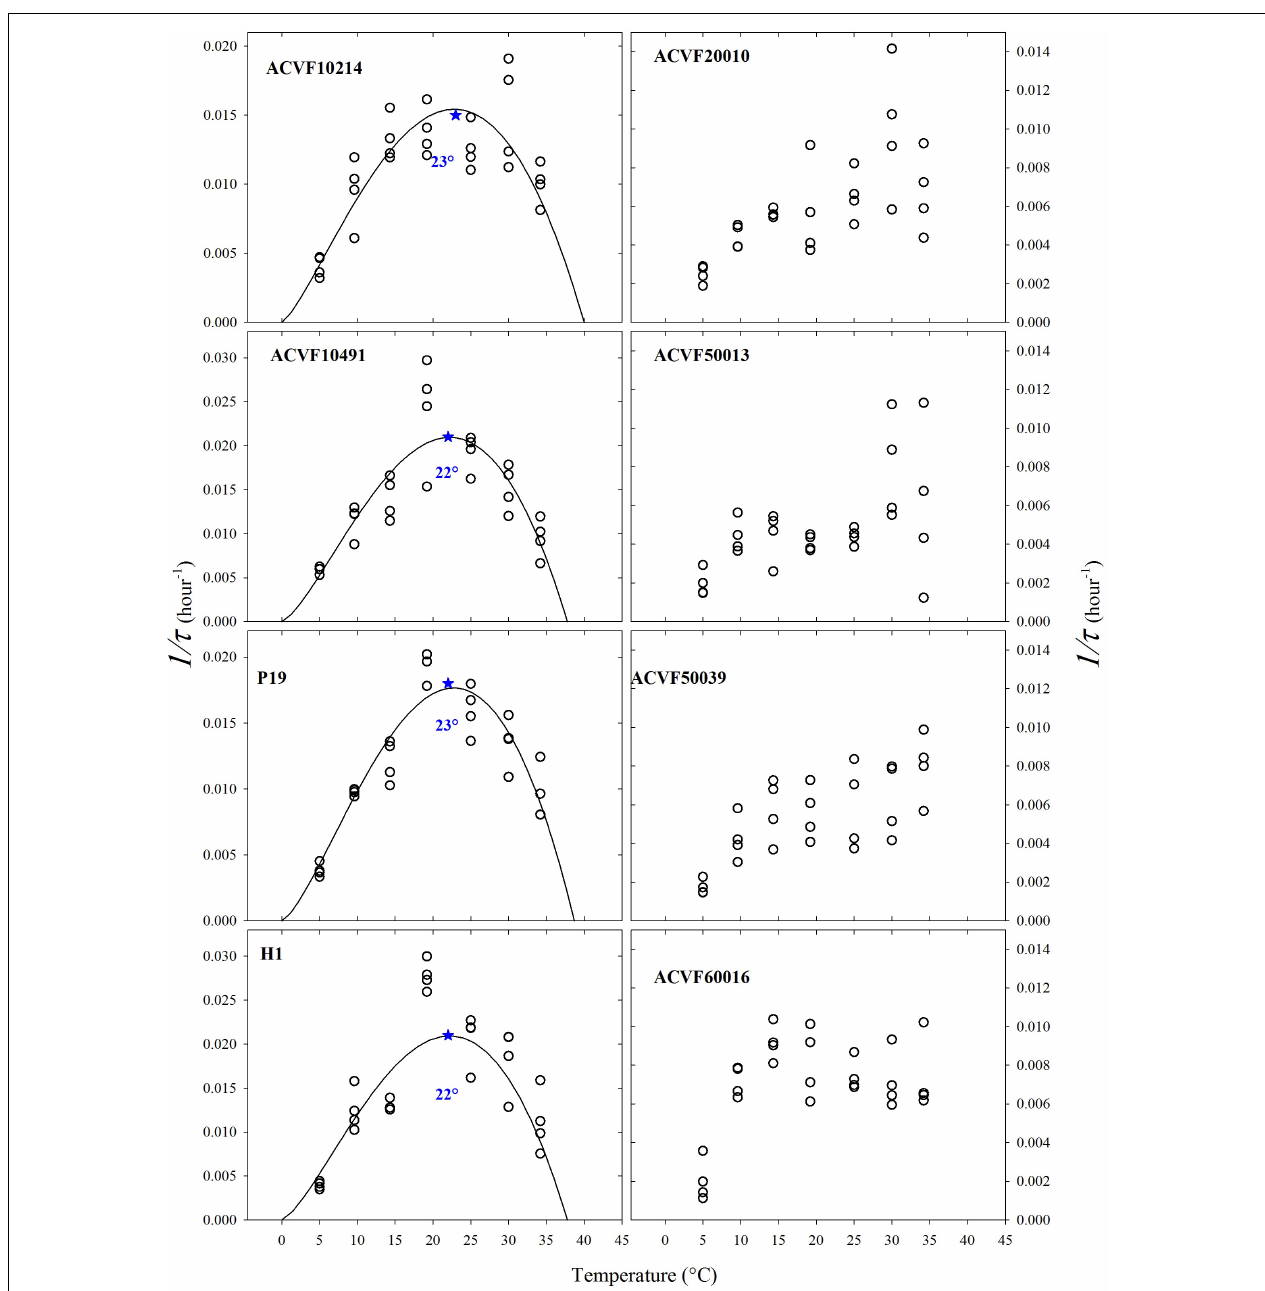
FIGURE 4 | The inverse of the time (1/ τ ) needed to obtain 50% of the germinating seeds germinated for eight accessions of Lolium perenne *indicates the estimated optimal temperature.